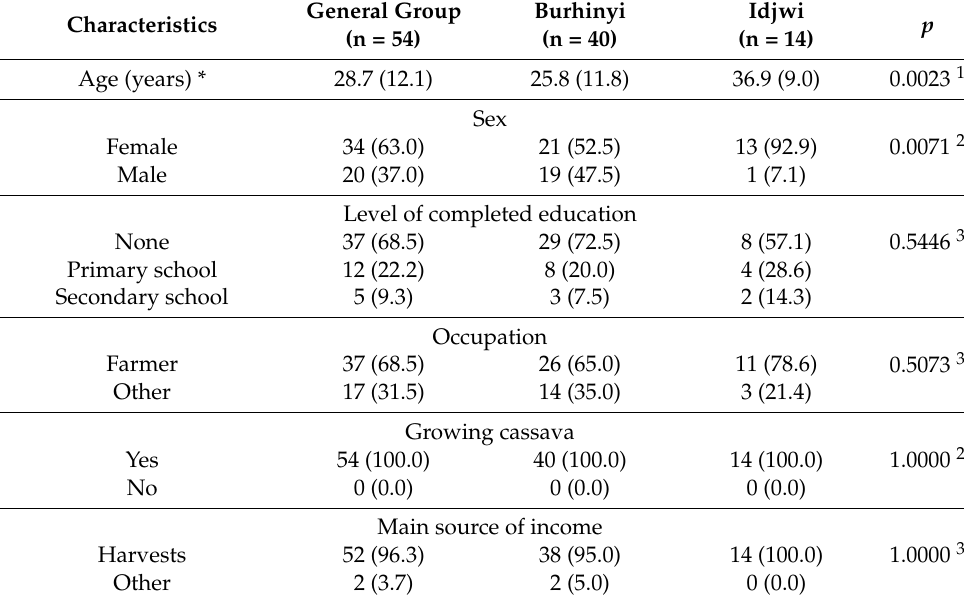
Table 1. Sociodemographic characteristics of the final study population. Characteristics